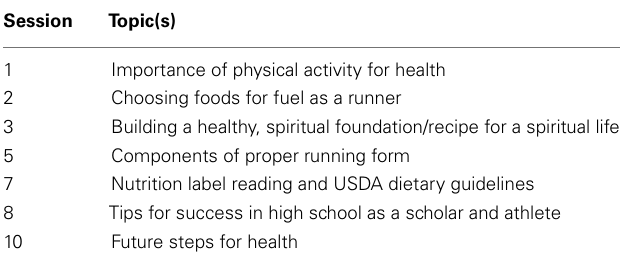
Table 2 | Select youth educational